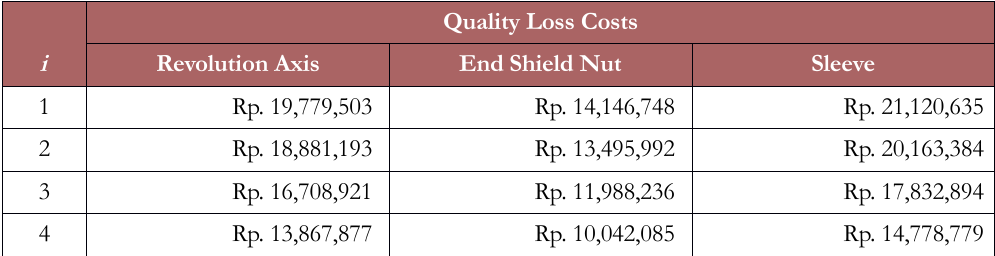
Table 28. Effects of learning cycles to quality loss